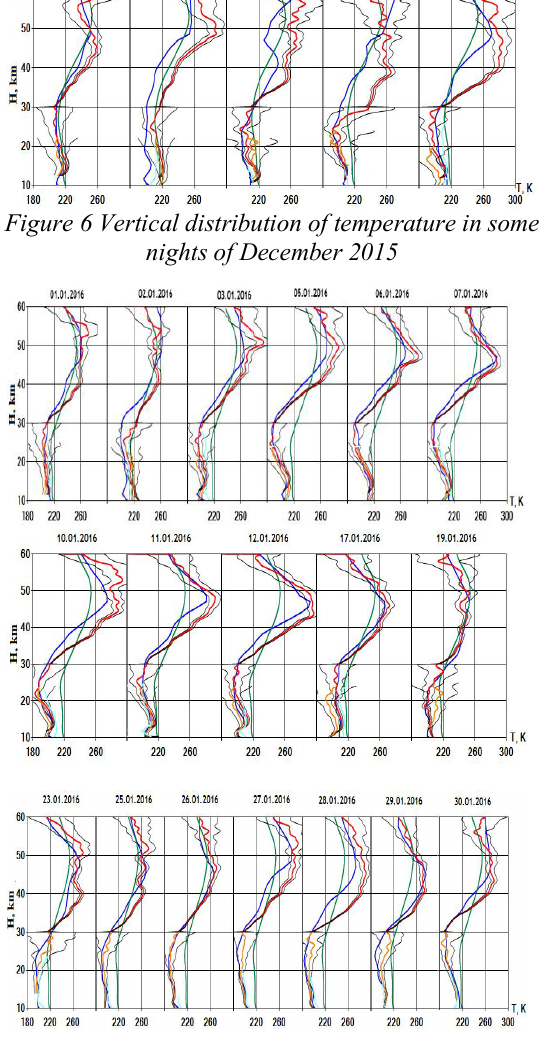
Figure 7 Vertical distribution of temperature in some nights of January 2016. The yellow line shows Raman lidar measurements, lower blue - radiosonde